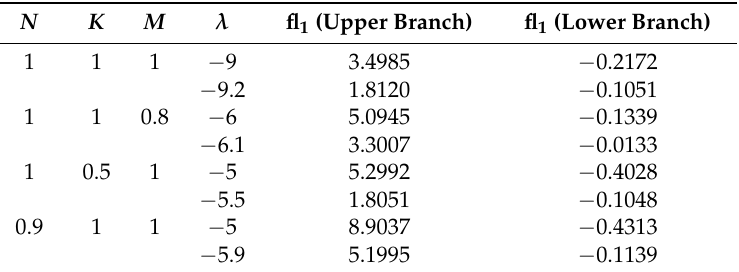
Table 3. Minimum eigenvalue, γ 1 at several values of N , K , M , and λ